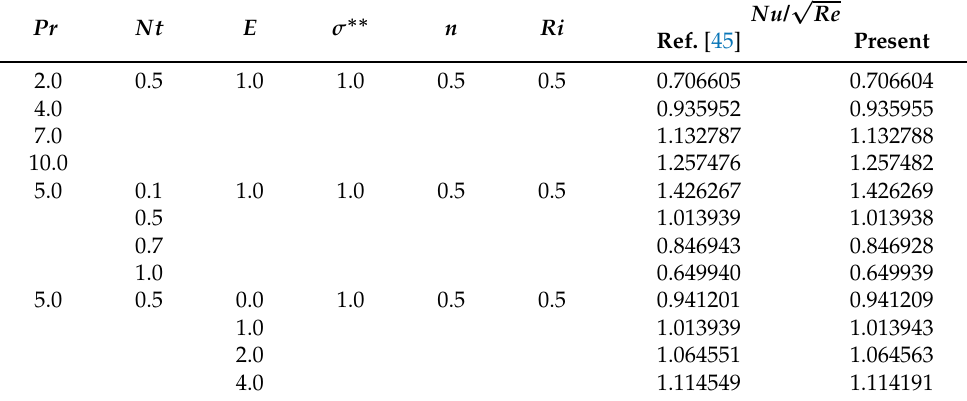
Table 4. Comparison of local Nusselt number when We = λ = Fr = R = Γ T = Hg = Γ C = 0